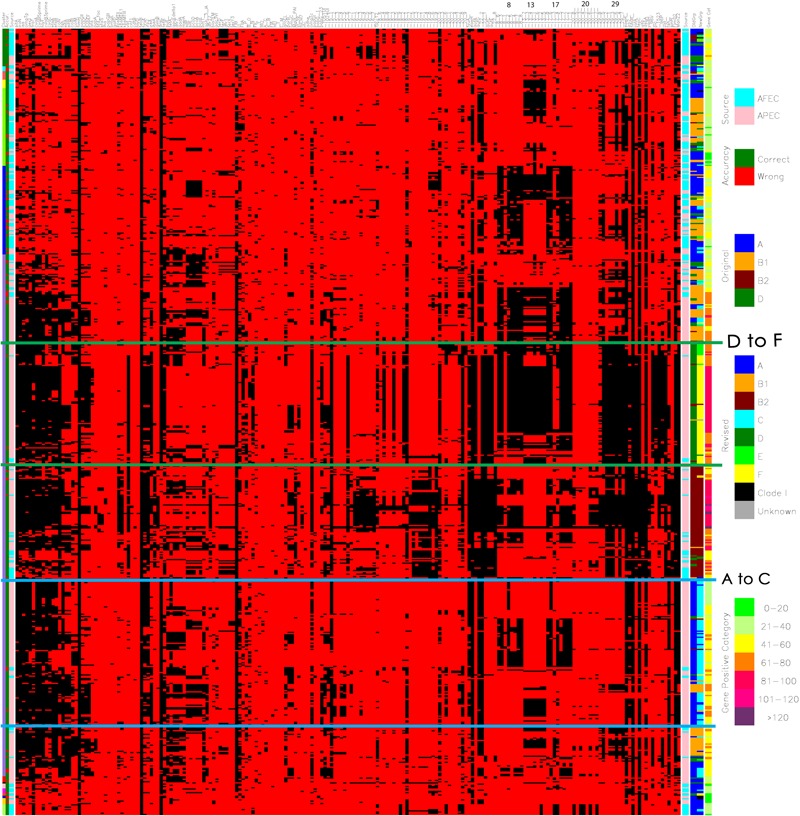
Diagram merging the cluster analysis and linear discriminant analysis (LDA) of the genotyping results of avian pathogenic E. coli (APEC) and avian fecal E. coli (AFEC) strains. The first row (the uppermost row at the top of the figure) identifies the genes that were screened for using multiplex PCR reaction a total of 208 genes are included here as described previously (Logue et al., 2012). The first column on the left indicates the numbers of clusters that the strains were located to – there are 15 indicated (1) Green; (2) Light blue; (3) Pink; (4) Yellow; (5) Lime green; (6) Dark blue; (7) Purple; (8) Red; (9) Black; (10) Salmon pink; (11) Magenta; (12) Orange; (13) Navy blue; (14) Dark yellow; (15) Light lime green. The second column shows the accuracy of prediction from the linear discriminant analysis (LDA) of an isolate type based on possession of genes/traits. Green indicates a correct prediction as to whether an isolate is an APEC or an AFEC strain, whereas red indicates a misprediction. The third column indicates the source of the isolates, where AFEC strains are denoted as light blue, and APEC strains are identified in salmon pink. The next set of columns of red and black bars shows the results of PCR for a single gene or trait. The identity of each gene tested is shown above the column at the far right of the diagram. In the body of the figure, a black line means that the gene of interest is present in a particular isolate, whereas a red line means the gene is absent. The column following the black and red pattern shows the source of the isolates (same as the third column). Column 206 (made up of brown, green, blue, and orange colors) indicates the phylogenetic groups of each isolate using the Clermont 2000 scheme: blue, phylogenetic group A; orange, B1; brown, B2; and green, D. Column 207 (made up of blue, orange, brown, light blue, green, lime green, yellow, black, and gray) indicates the phylogenetic groups of each isolate using the Clermont 2013 scheme: blue, phylogenetic group A; orange, B1; brown, B2; and light blue. C; green, D; lime green E; yellow, F; black, clade 1; gray, unknown. Column 208 indicates the indicates the gene/trait content for each strain, where isolates in category 1 contain 1 to 20 of the tested genes/traits and are identified as lime green; category 2 isolates are identified in light lime green and possess 21 to 40 genes; category 3 isolates are identified in yellow and possess 41 to 60 genes; category 4 isolates are identified in orange and possess 61 to 80 genes; and category 5 isolates are identified in red and possess 81 to 100 genes. Category 6 isolates are identified in magenta and possess 101–120 genes while category 7 identifies isolates in purple possessing > 120 genes. Above the columns on the right side of the image some of the pathogenicity islands have been indicated by the numbers 8, 13, 17, 20, and 29. Detail view available at: https://figshare.com/s/550bc7f2b3eadd69889e.